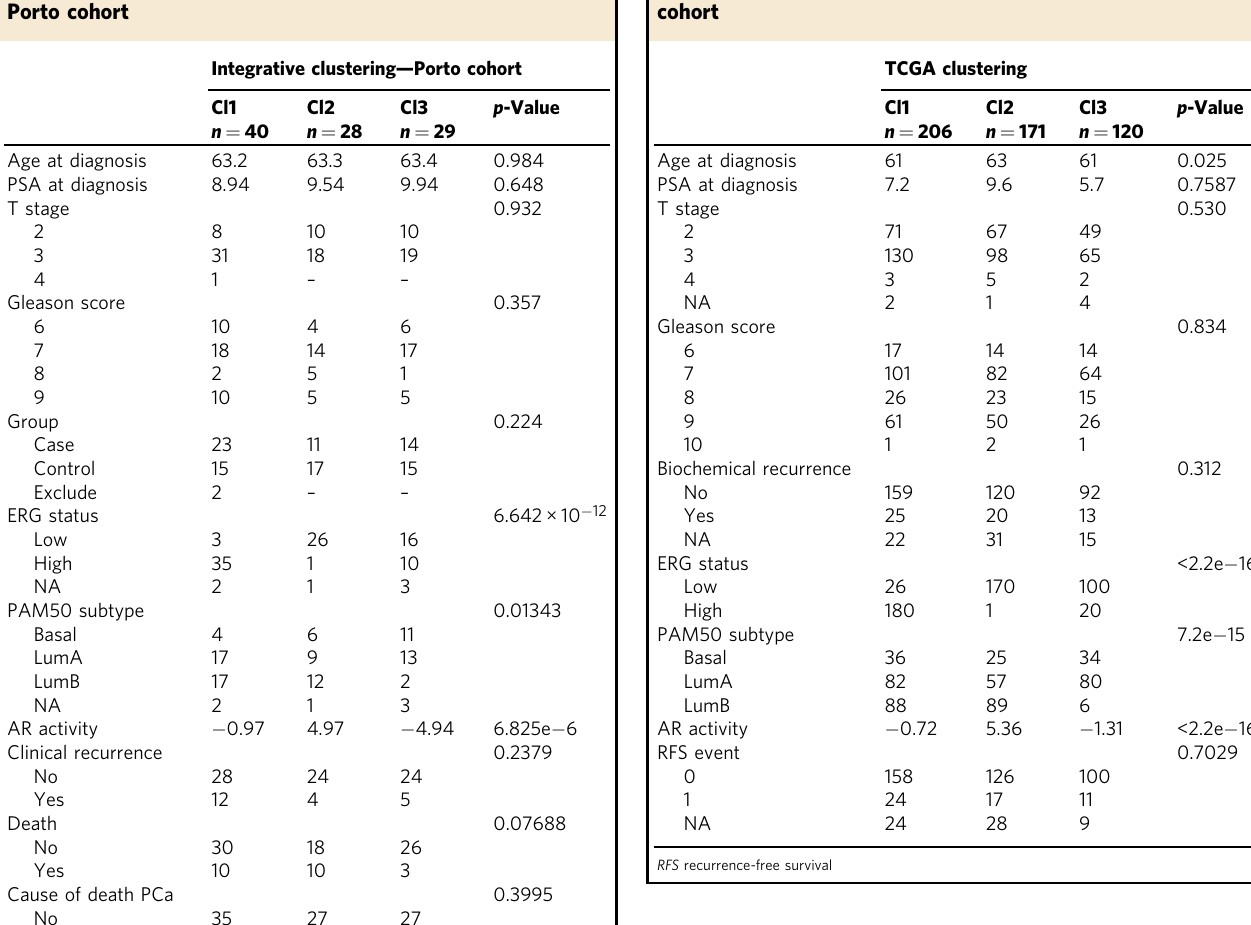
Fig. 5 Validation and characterization of three subtypes. a On the left: unsupervised hierarchical clustering of 285 differentially expressed genes between the three integrative clusters. The sample classi fi cation according to integrative cluster analysis is indicated below the branching. On the right: unsupervised hierarchical clustering on the TCGA cohort using the genes differentially expressed across the three clusters of the Porto cohort. The genes (rows) in the heatmap are ordered the same as for the Porto cohort. Color scale: red indicates high expression an blue low expression ( z -score). b Heatmap of copy number alterations (CNAs) of 88 Porto samples (left) and TCGA samples (right). Samples from Porto and TCGA cohort are ordered the same as in Figs. 4a and 5a, respectively. Red and blue represent copy number gains and losses, respectively. c CNA burden as fraction of the genome that is copy number altered in the Porto cohort (left) and TCGA cohort (right). Boxplot: median values with interquartile range. p -Values were calculated using the Wilcoxon test. d Boxplot (median values with interquartile range) showing the number of genes with a mutation for the three clusters in the TCGA cohort. p -Values were calculated using the Wilcoxon test. e Association of mutation with the three clusters identi fi ed in the TCGA cohort. Only genes with signi fi cant differential enrichment among the clusters are shown (FDR < 0.2). Percentages on the left show the mutation frequency. f p -Values for top gene sets enriched (FDR < 0.2) from the MSigDB collection of “ curated ” gene sets in any of the three clusters, represented in a radar plot for Porto (left) and